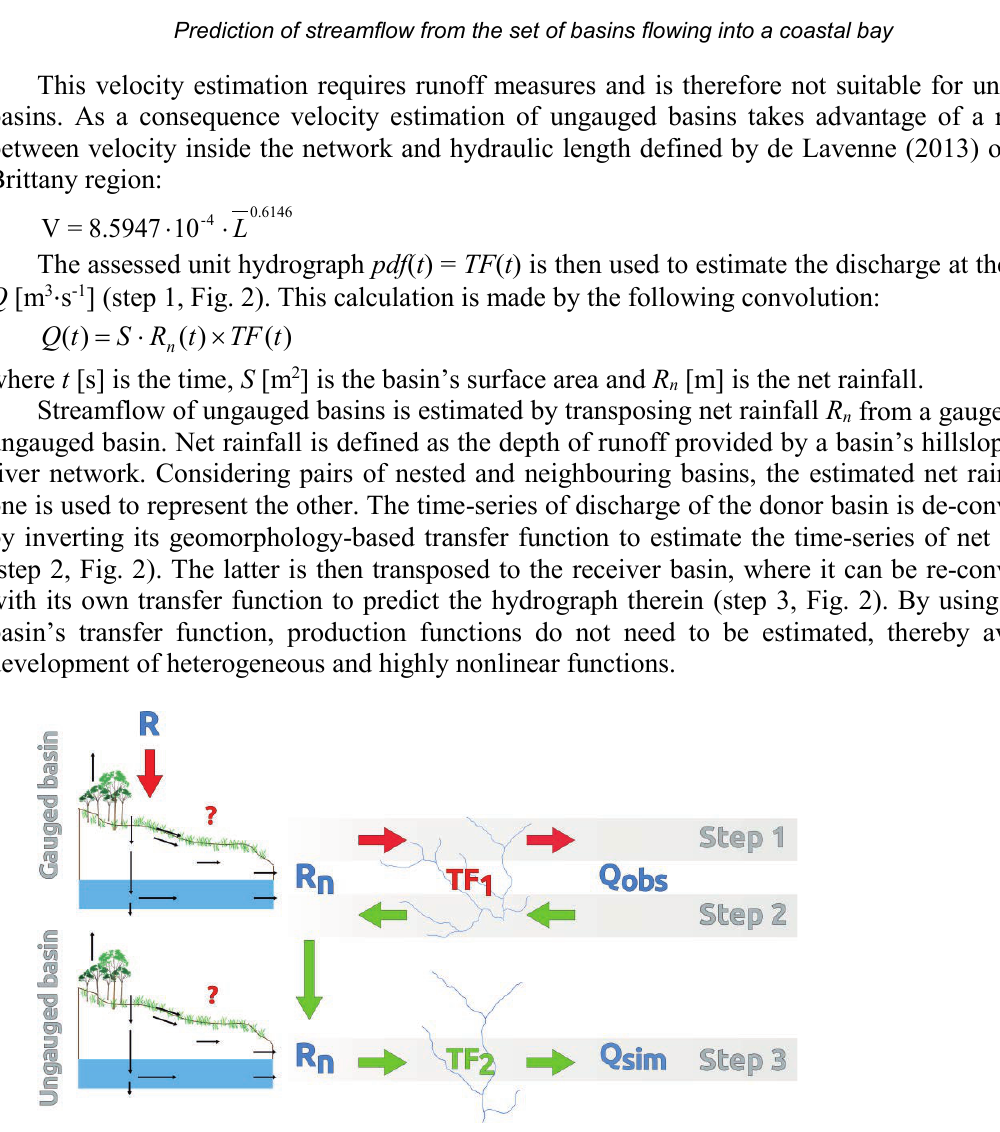
Fig. 2 Principle of hydrograph transposition (derived from de Lavenne et al.